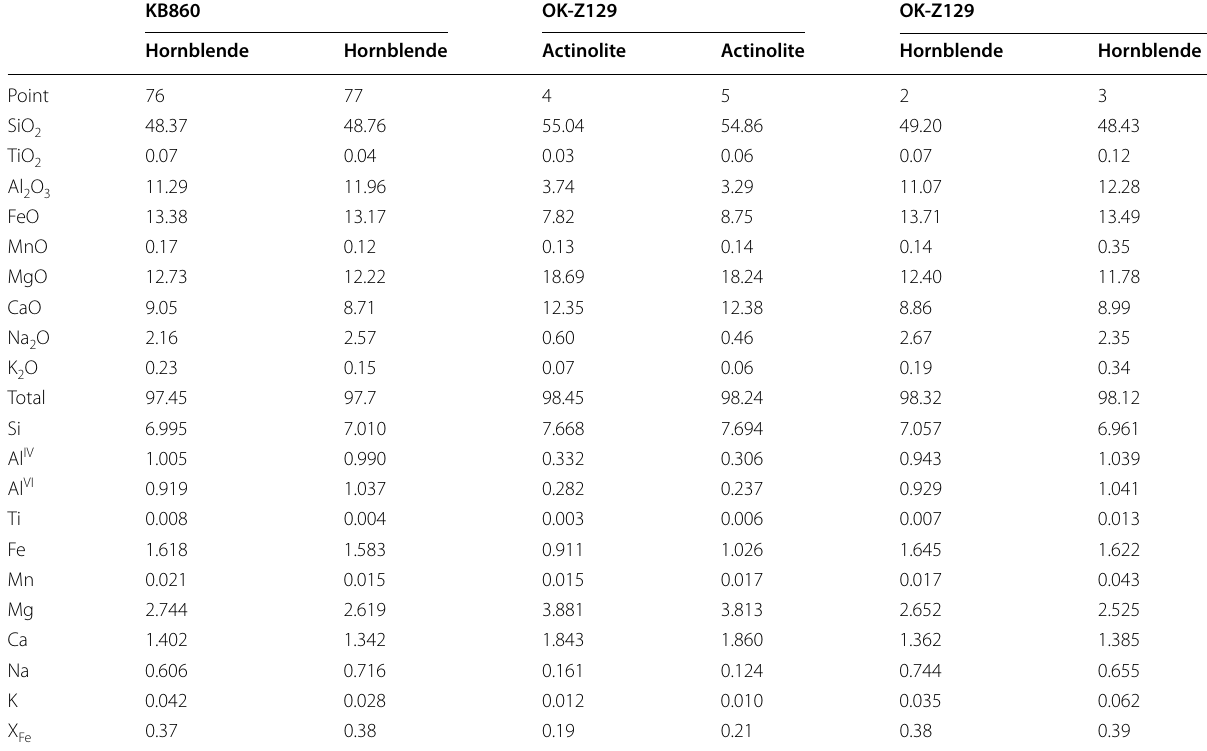
Formula based on 23 oxygen